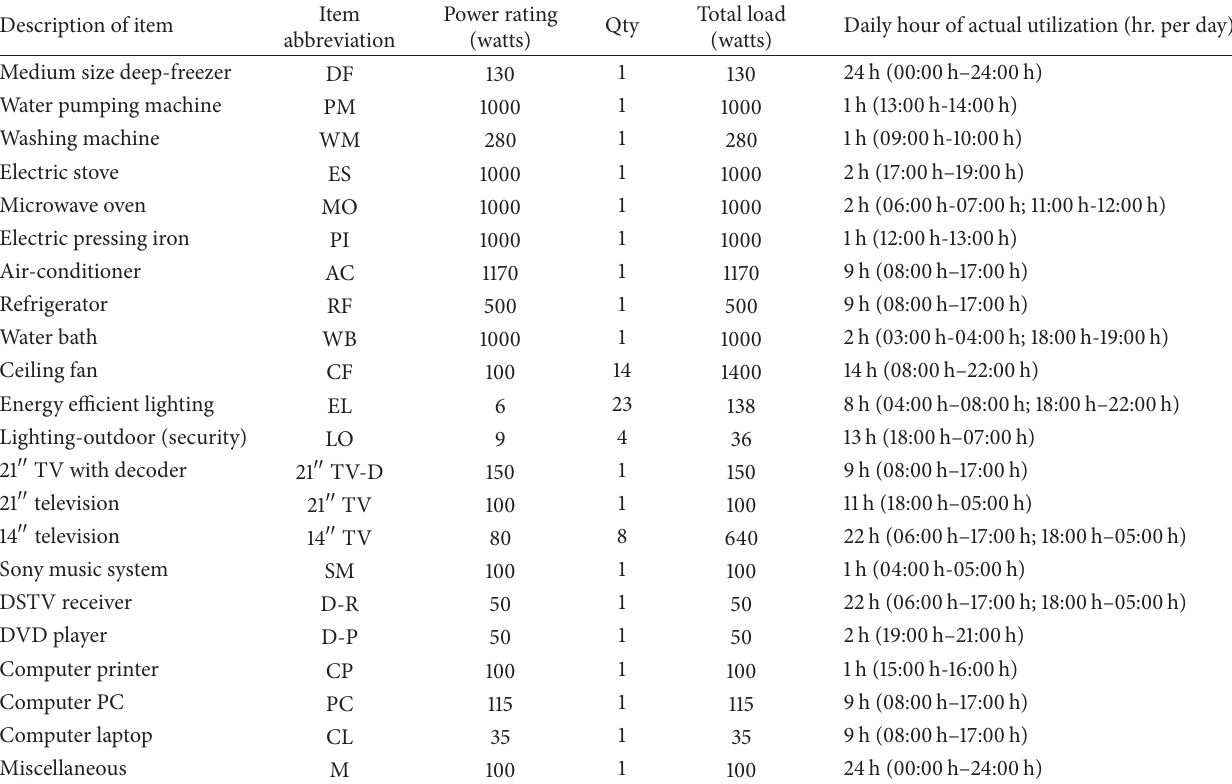
Table 1: Energy needed for the household